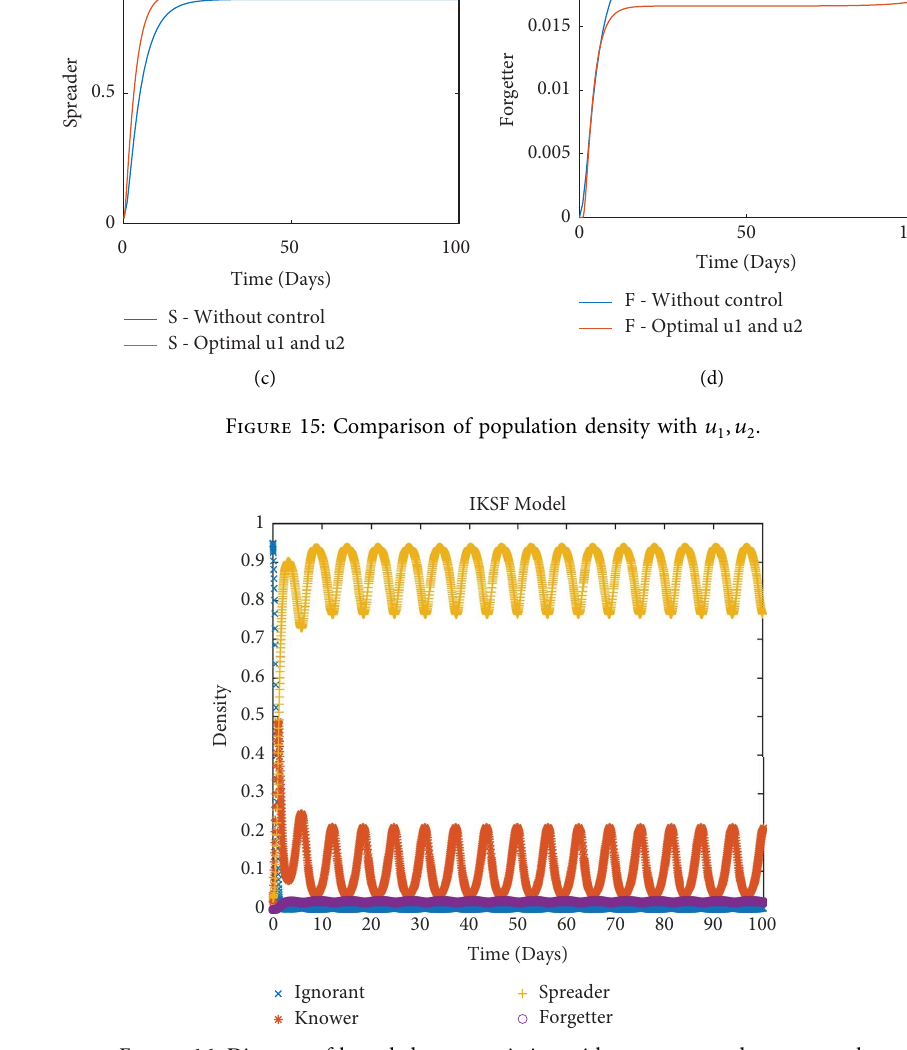
Figure 16: Diagram of knowledge transmission without guaranteed cost